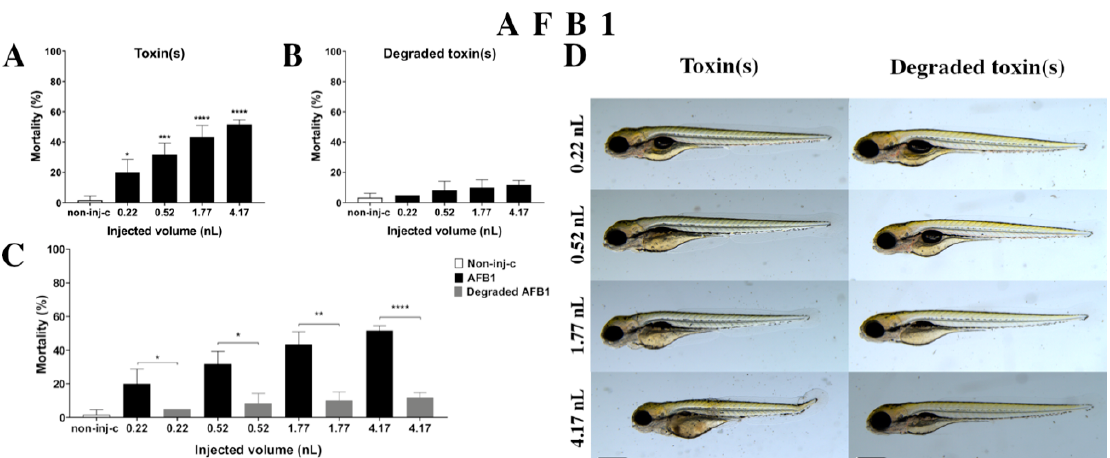
Figure 2. Effects of AFB1 ( A ) and its degradation products ( B ) by the Rhodococcus erythropolis NI1 strain on 120 hpf zebrafish embryos. Mortality data are expressed as mean ± SD from three independent experiments in triplicate. Kruskal–Wallis followed by Dunn’s post-hoc test and Mann–Whitney test were used. Mortality values were compared to the non-injected control (non-inj-c) (* p < 0.05, *** p < 0.001, **** p < 0.0001); lethality results of initial AFB1 were compared to the degradation products of AFB1 ( C ) (* p < 0.05, ** p < 0.01, **** p < 0.0001). AFB1 and its degradation products induced developmental dysfunctions ( D ) in zebrafish embryos examined at 120 h. Representative phenotypic deformities induced by AFB1 were deformed tail, yolk edema, and swim bladders were not developed at 0.52, 1.77, and 4.17 nL doses; sublethal effects of the degradation products of AFB1 were not detected at either dose. Scale bar: 1 mm. The frequency of malformations of treated groups were compared to the non-injected control (non-inj-c) (Figure 1C). Quantitative data of developmental dysfunctions in zebrafish embryos are in the Supplementary Materials (Supplementary Table S1).